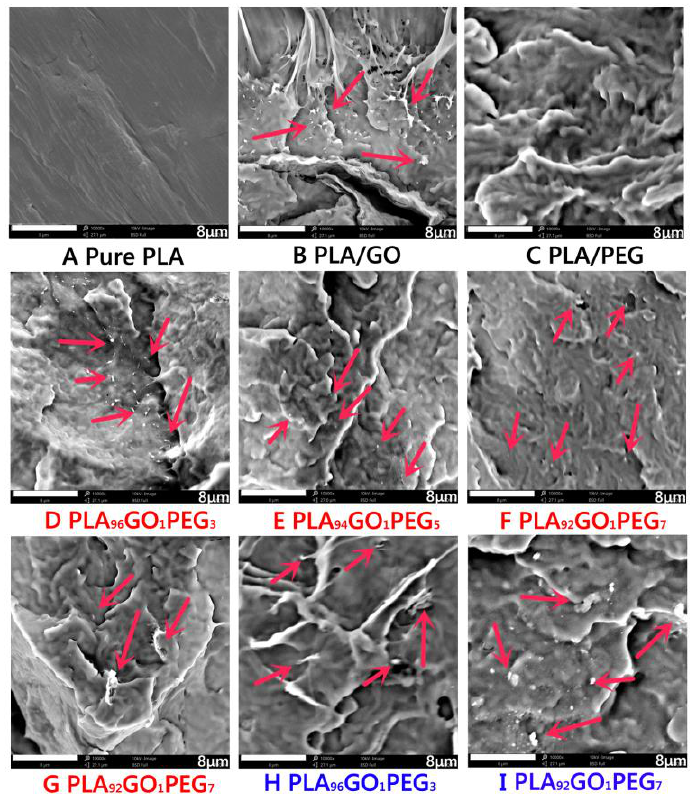
Figure 5. SEM images of pure PLA, GO/PLA, PEG/PLA, and GO/PEG/PLA multi-phase composites with different component ratio under different melt-compounding.